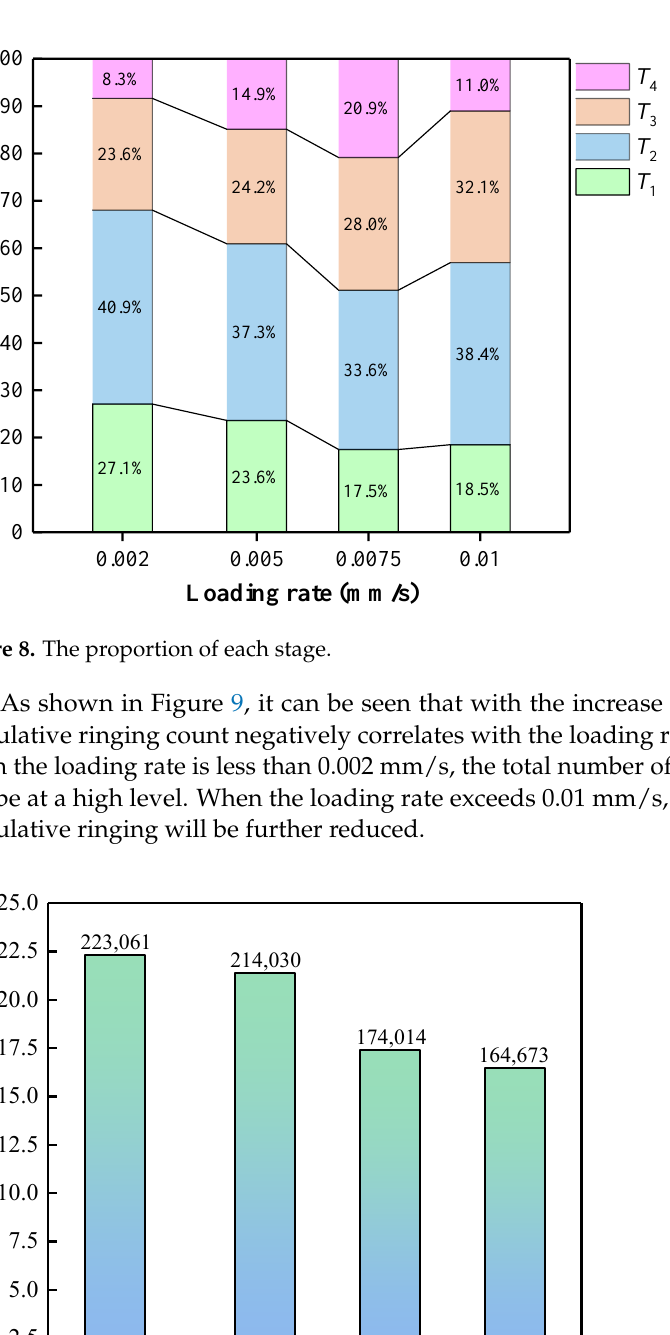
Figure 7. AE ringing counts, stress and time curves of ASPM specimens. ( a ) 0.002; ( b ) 0.005; ( c ) 0.0075; ( d ) 0.01.